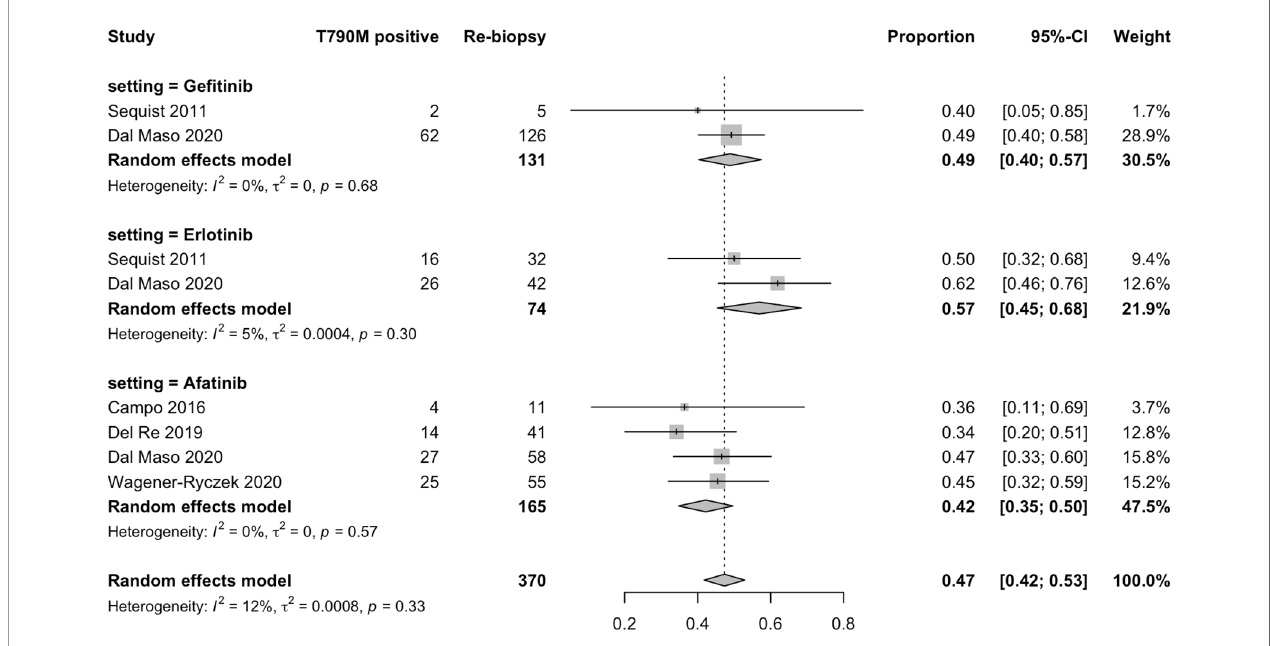
FIGURE 5 | Forest plot of subgroup single-arm meta-analysis of Caucasian